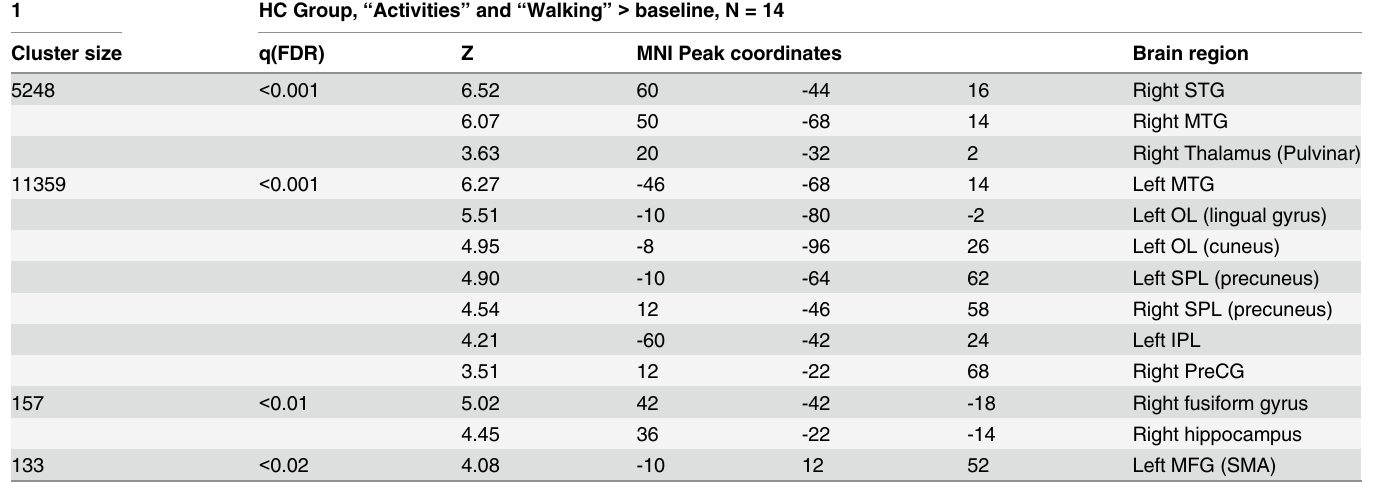
Table 1. Brain Activity of the healthy controls (HC) group, peak activations. Cluster maxima of brain activity of the video clips of activities of daily living ( “ Activities ” ) and walking activities ( “ Walking ” ) together. All results are false discovery rate corrected (FDR, q < 0.05). MNI = Montreal Neurological Institute, STG = superior temporal gyrus, MTG = middle temporal gyrus, MFG = middle frontal gyrus, OL = occipital lobe, SPL = superior parietal lobule, IPL = inferior parietal lobule, PreCG = precentral gyrus, DLPFC = dorsolateral prefrontal cortex. 1 HC Group, “ Activities ” and “ Walking ” > baseline, N = 14 MNI Peak coordinates Brain region